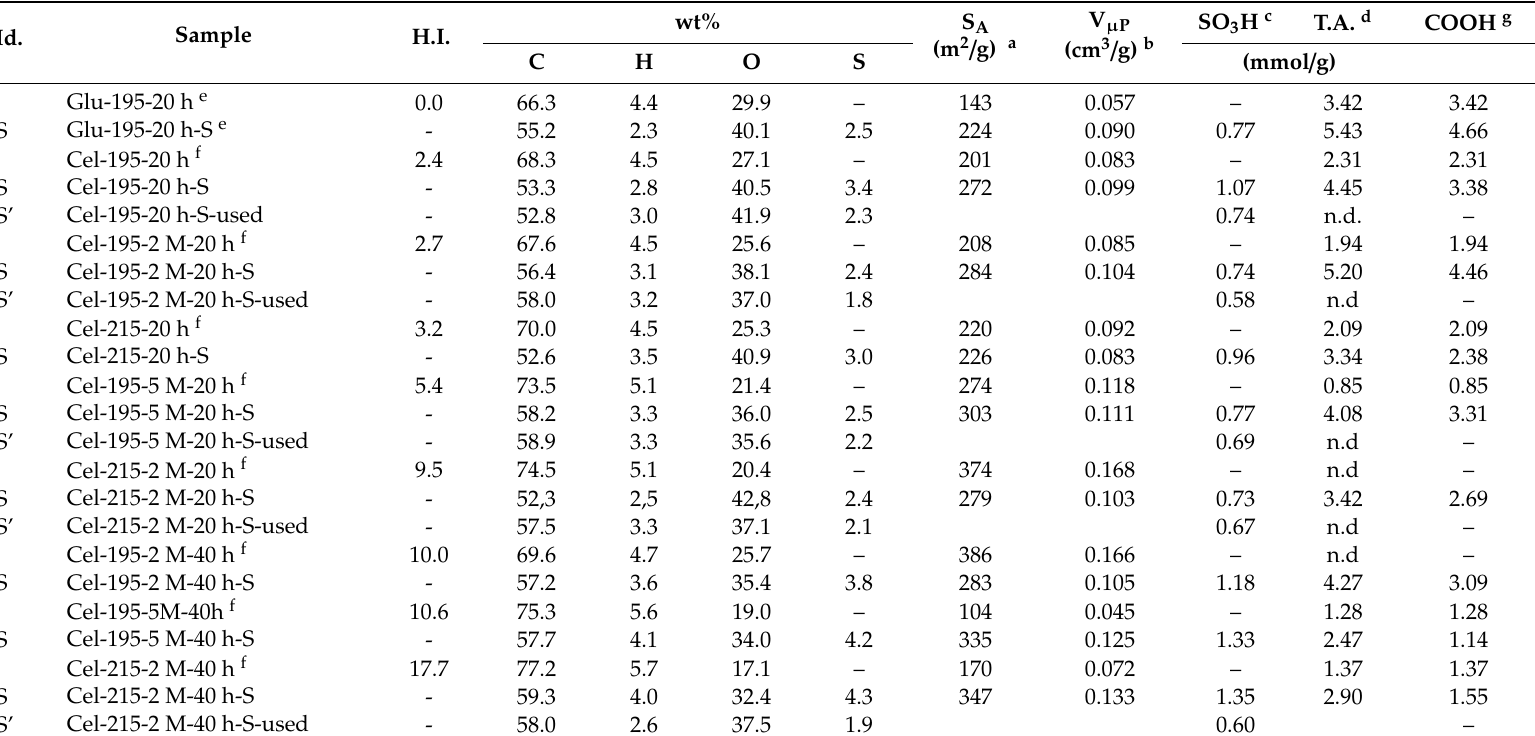
Table 1. Composition, textural properties and acidity of HTC and SHTC